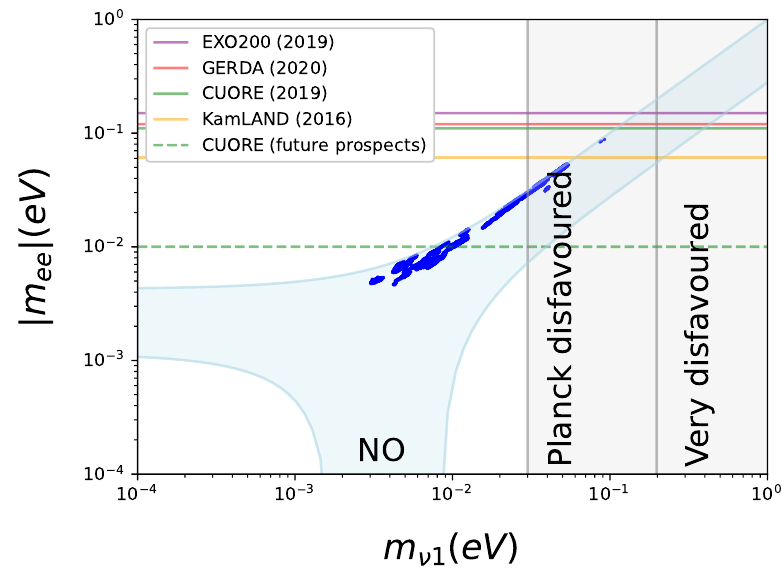
Figure 5 . The dark blue points are the model prediction of the neutrinoless double beta decay parameter | m vs the mass of the lightest neutrino m . The light blue shaded region shows ee | ν 1 the allowed range in this plane for a normal hierarchy as predicted by the model. The vertical grey shaded bands to the right show the current Planck disfavoured region [76], while the coloured horizontal lines show the limits on | m from KamLAND [77], EXO-200 [78], CUORE [79], and ee | GERDA [80]. We also indicate future prospects for CUORE